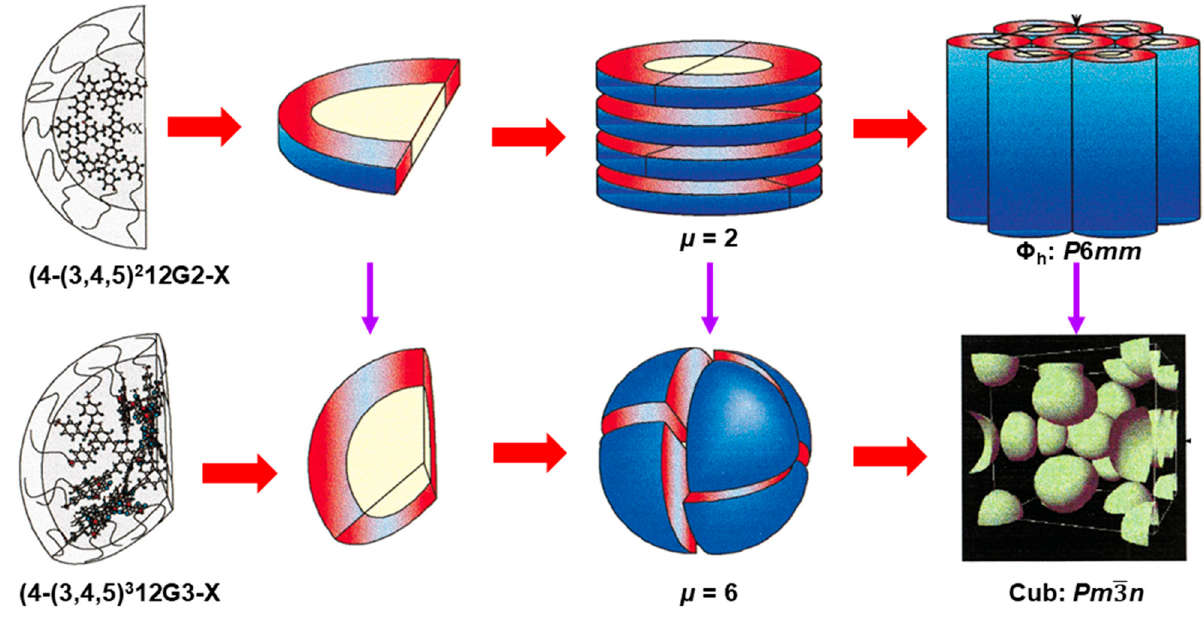
Figure 11. Hierarchical self-organization of the same self-assembling dendron at two different generations. (4-(3,4,5) 2 12G2-X is second generation (top), and (4-(3,4,5) 3 12G3-X is third generation (bottom) self-assembling dendron self-assembling columnar and, respectively, spherical assemblies − generating columnar hexagonal and cubic Pm 3 n or A15 Frank–Kasper phases [124]. Parts of the Figure were adapted and modified from [124]. Copyright © 1998, American Chemical